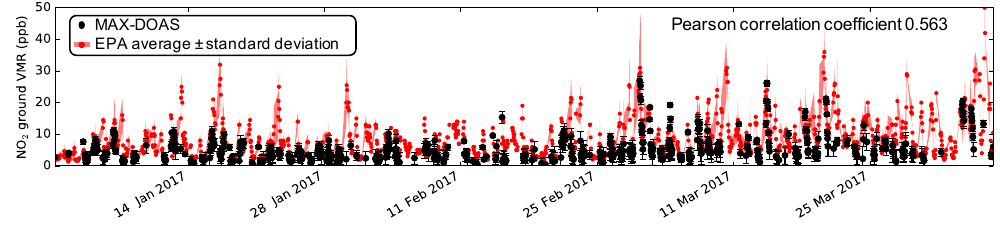
Figure 6. Time series comparison of MAX-DOAS-measured NO 2 VMR in the lowest retrieval layer at Broadmeadows (black) vs. average NO 2 for the four Melbourne EPA monitoring sites (red). All measurements are hourly averages during daylight hours